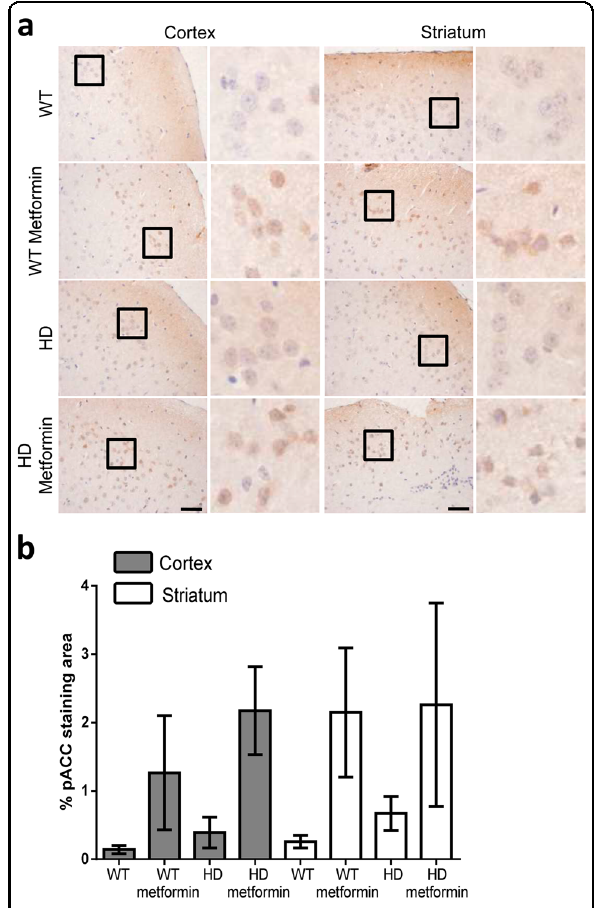
Fig. 3 Levels of phospho-acetyl CoA carboxylase (pACC), a substrate of AMP-activated protein kinase (AMPK), in brain tissue of 6-month-old control and zQ175 mice treated or not with metformin. a Immunohistochemical (IHC) staining illustrates the expression levels of pACC in the cortex and striatum of zQ175 (Huntington disease (HD)) mice and their corresponding controls (wild type (WT)). Representative images of each condition are shown (bars: 50 µm). Boxed areas are enlarged, with a higher magni fi cation, on the right side of each image. b The bottom panel shows a semiquantitative analysis of IHC staining using the ImageJ software. Samples from four independent mice from each group were analyzed, which generated 7 cortex and 12 striatum pictures from untreated wild-type (WT) mice, 9 cortex and 12 striatum pictures from treated wild-type (WT metformin) mice, 7 cortex and 6 striatum pictures from untreated zQ175 (HD) mice, and 10 cortex and 6 striatum pictures from HD-treated (HD metformin) mice. The analyzed area in each picture was 90,488 μ m 2 . Treated mice showed increased levels of pACC, independent of their genotype ( p < 0.001). Values are the mean, and bars indicate the con fi dence interval (95% CI)